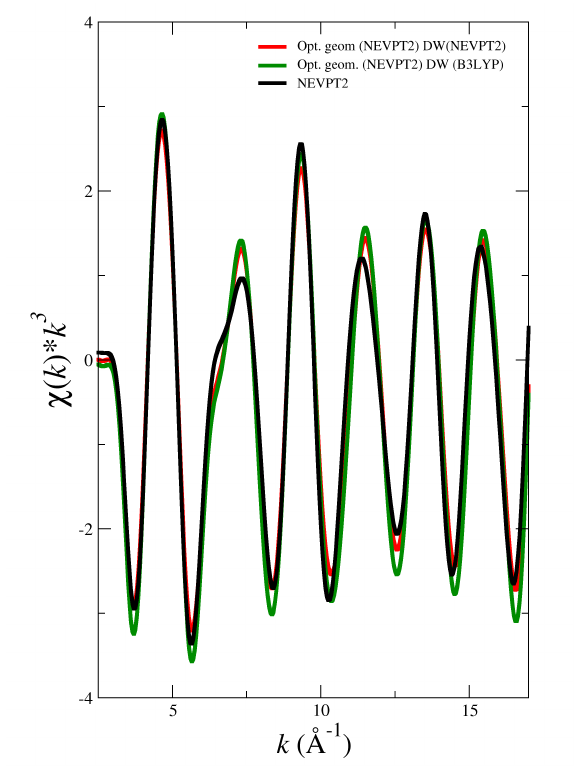
Figure 7. L III -edge k 3 -weighted simulated EXAFS spectra for NpO + the NEVPT2 force field (black line) and the NEVPT2 optimized geometry using the DW factors of the NEVPT2 MD simulation (red line) or the B3LYP MD simulation (green